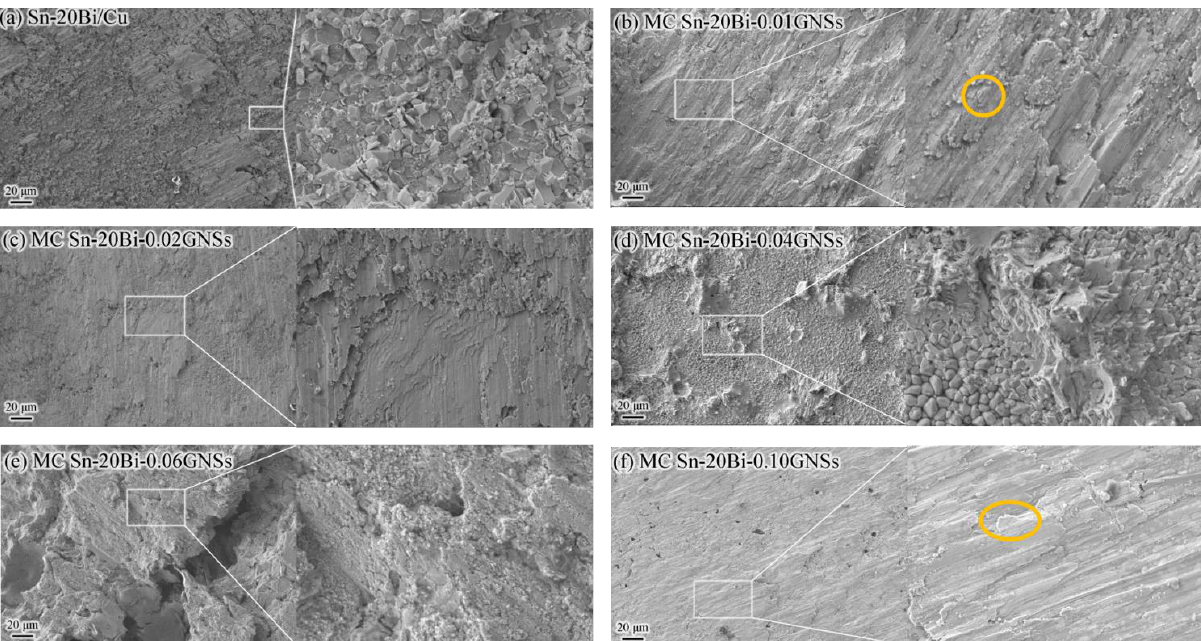
Figure 7. SEM images of MC Sn-20Bi- q GNSs/Cu solder joint after shear fracture: ( a ) q = 0, ( b ) q = 0.01, ( c ) q = 0.02, ( d ) q = 0.04, ( e ) q = 0.06, and ( f ) q = 0.10.